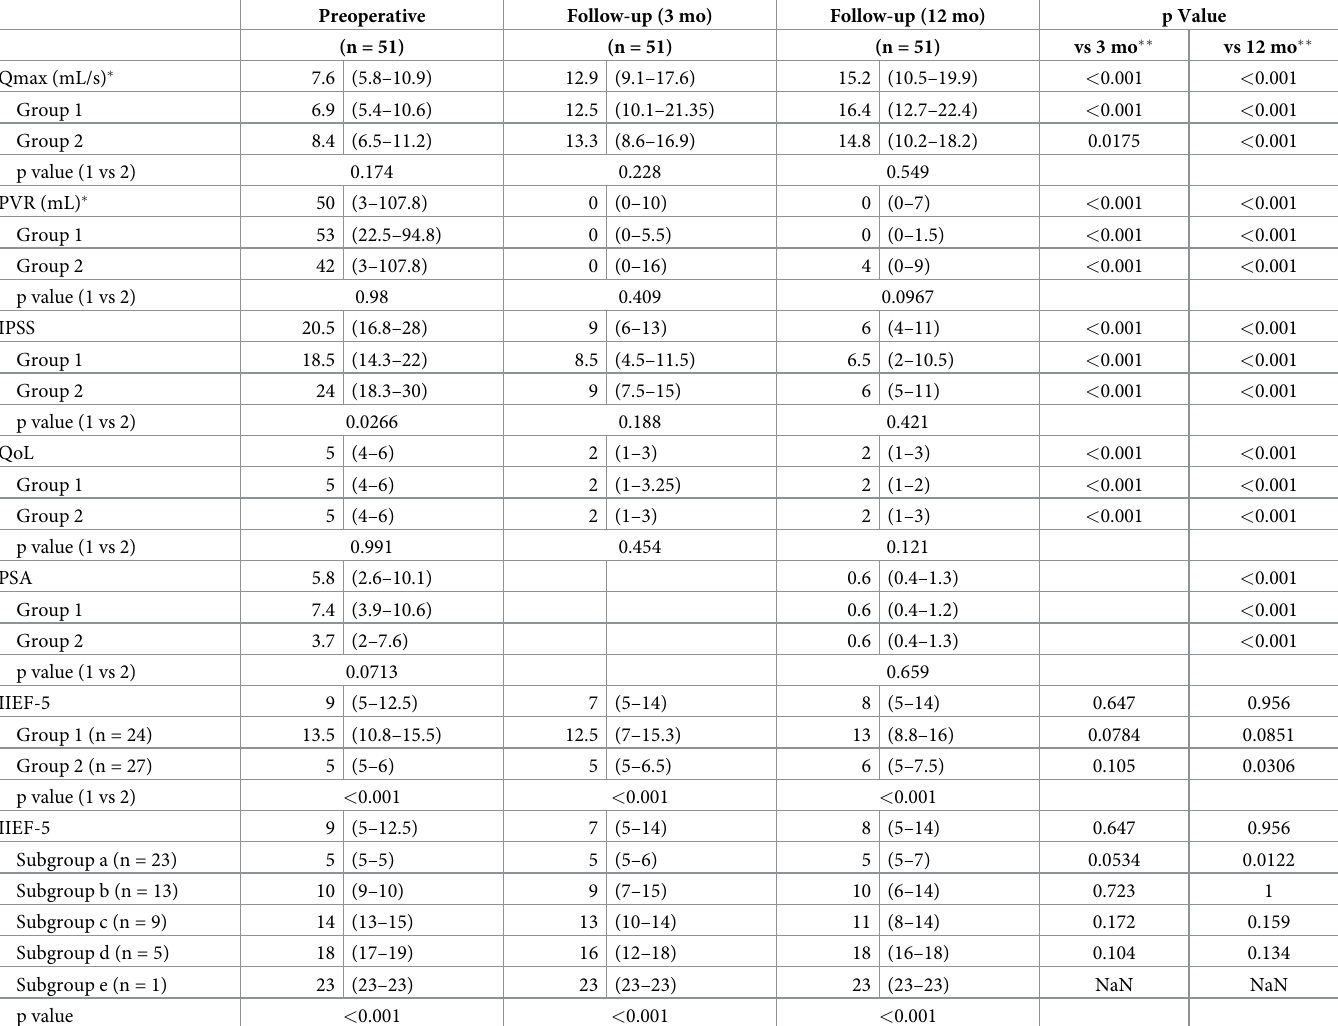
Table 4. Preoperative and follow-up